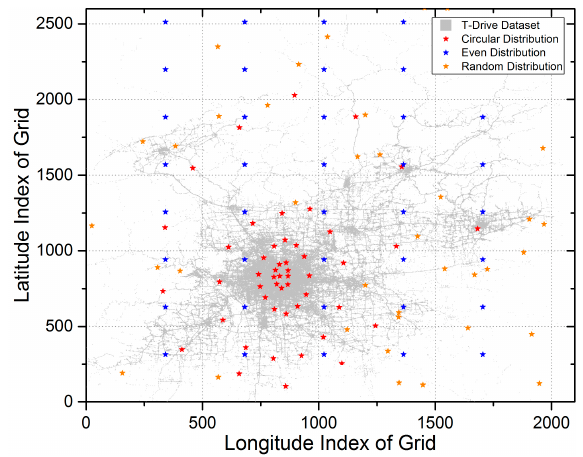
Figure 16. Locations of data centers with three different distributions.